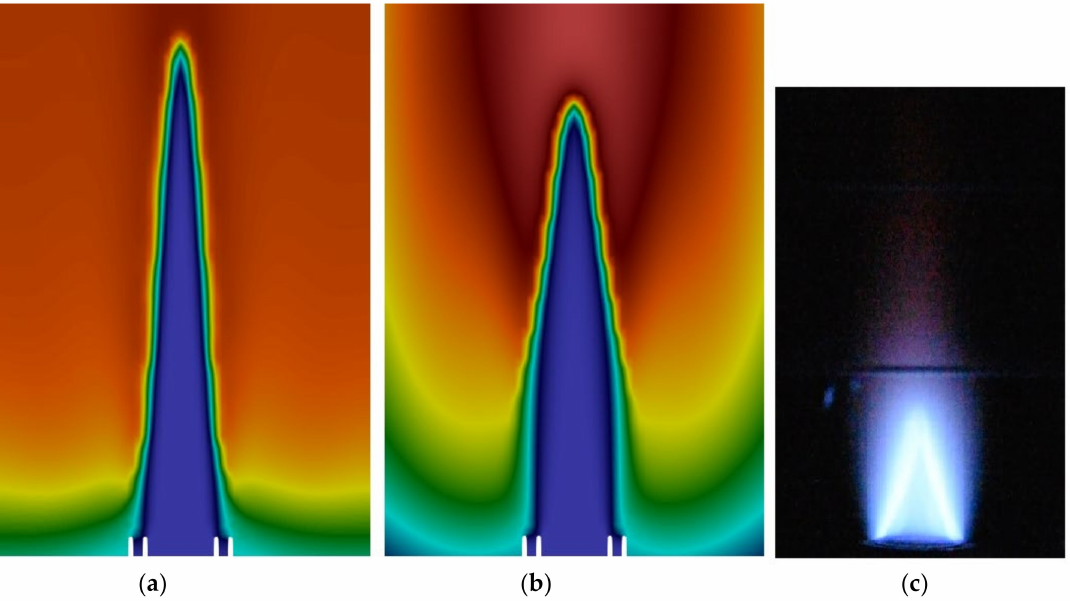
Figure 6. Contour of the flame temperature: ( a ) LES and ( b ) URANS in comparison with ( c ) the experiment.